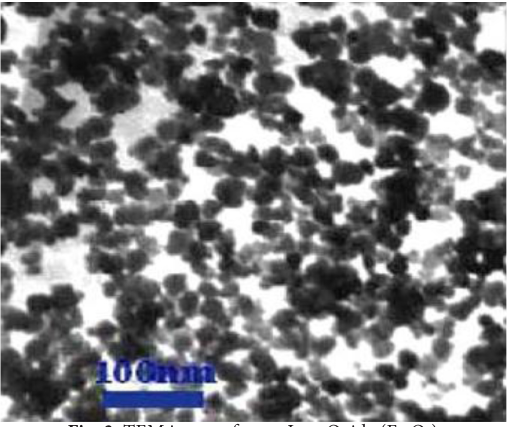
O ) Fig. 4. SEM image of Iron Oxide (Fe 3 4